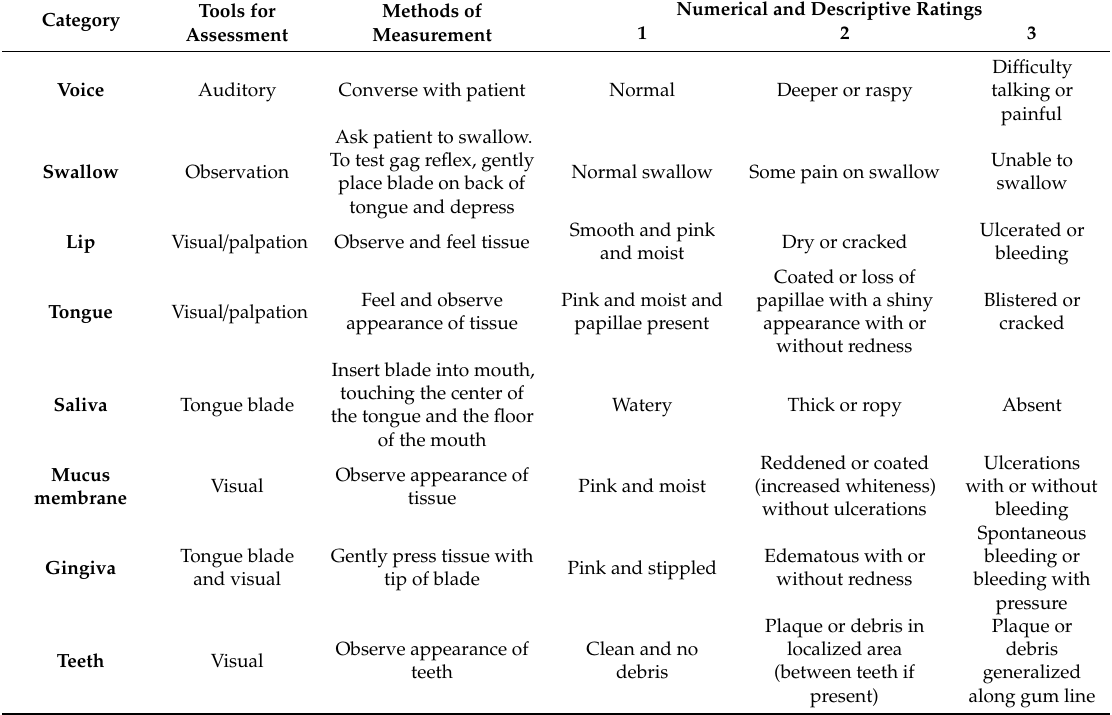
Table 4. Oral assessment guide of oral